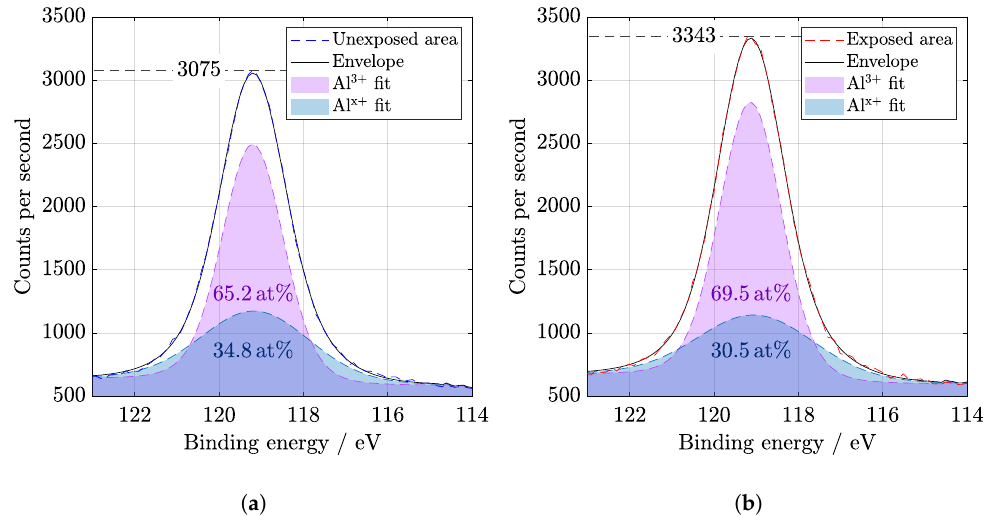
Figure 9. High resolution of Al2s region from XPS ( a ) before and ( b ) after SL irradiation of 67 days. Binding energy value of deconvoluted oxidation states for Al 3 + is 119.1 eV and for Al x + is 119 eV. The relative change in energy is indicated by a difference in the structure composition of anti-reflection coating elements.